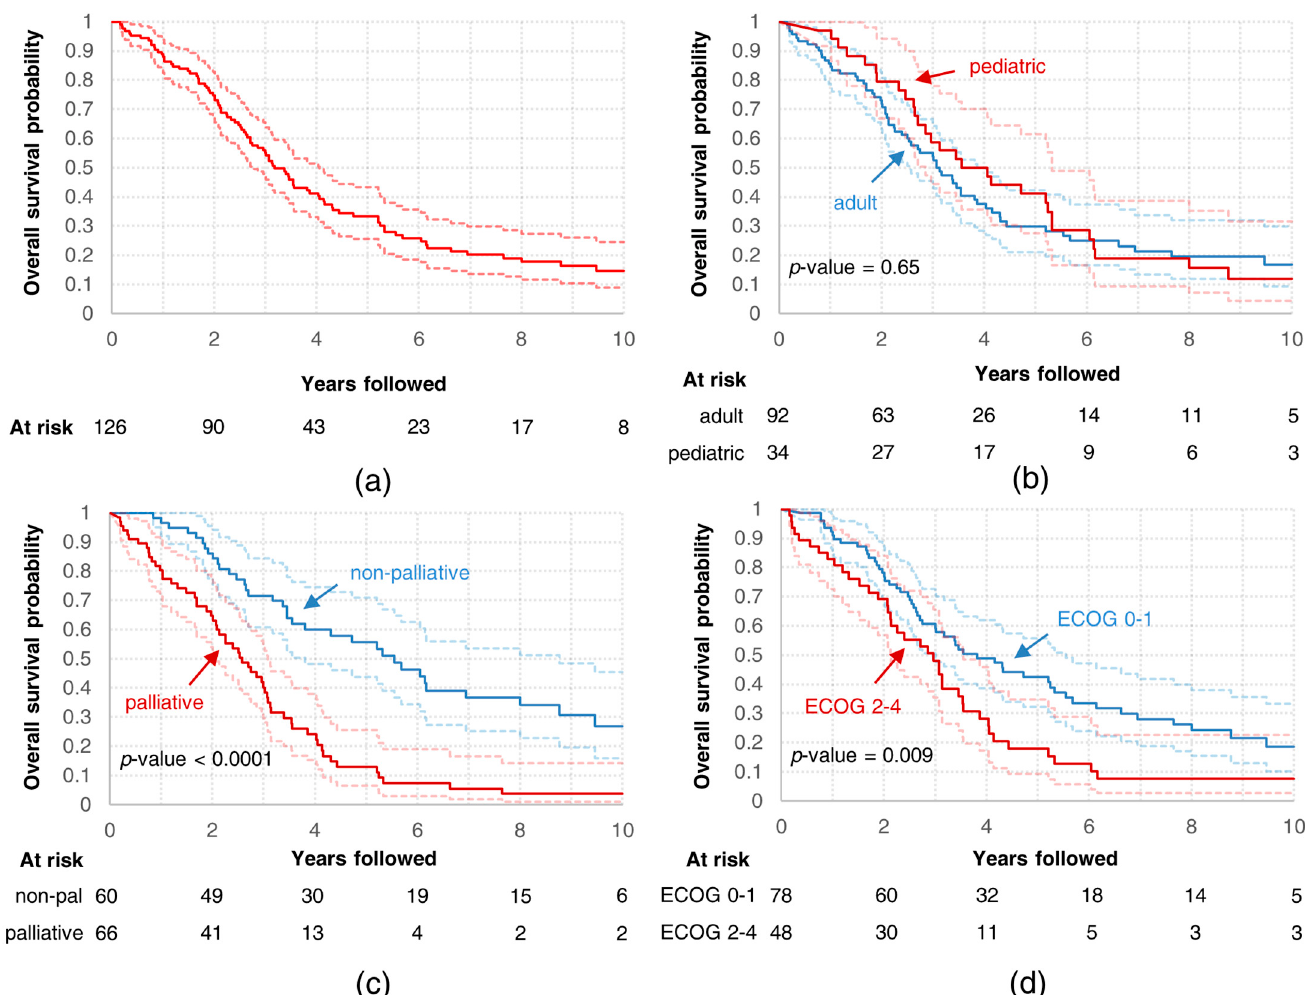
Figure 3. Overall survival curves for ( a ) all analyzed patients; all analyzed patients divided into subgroups based on ( b ) age, ( c ) intent of radiotherapy, and ( d ) performance status.